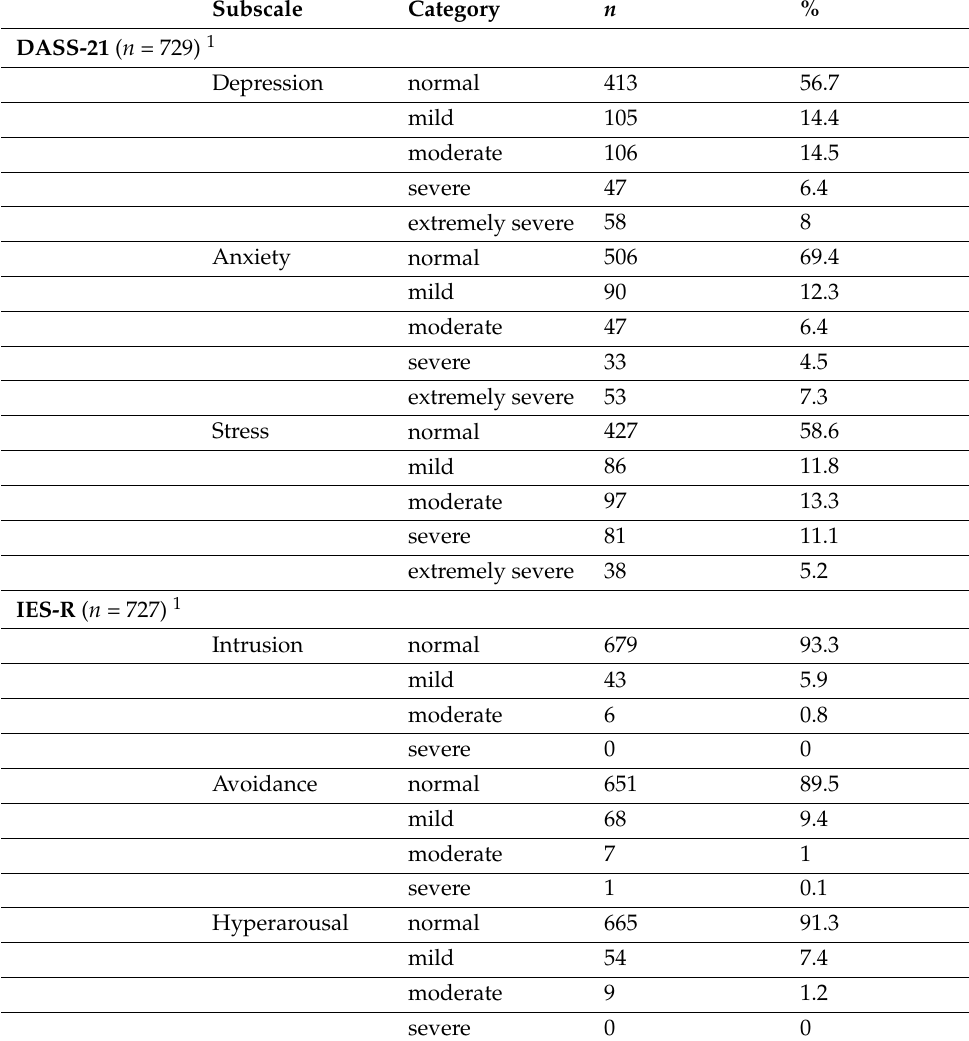
Table 3. Amount of dentists and total population percentage for each DASS-21 and IES-R subscale